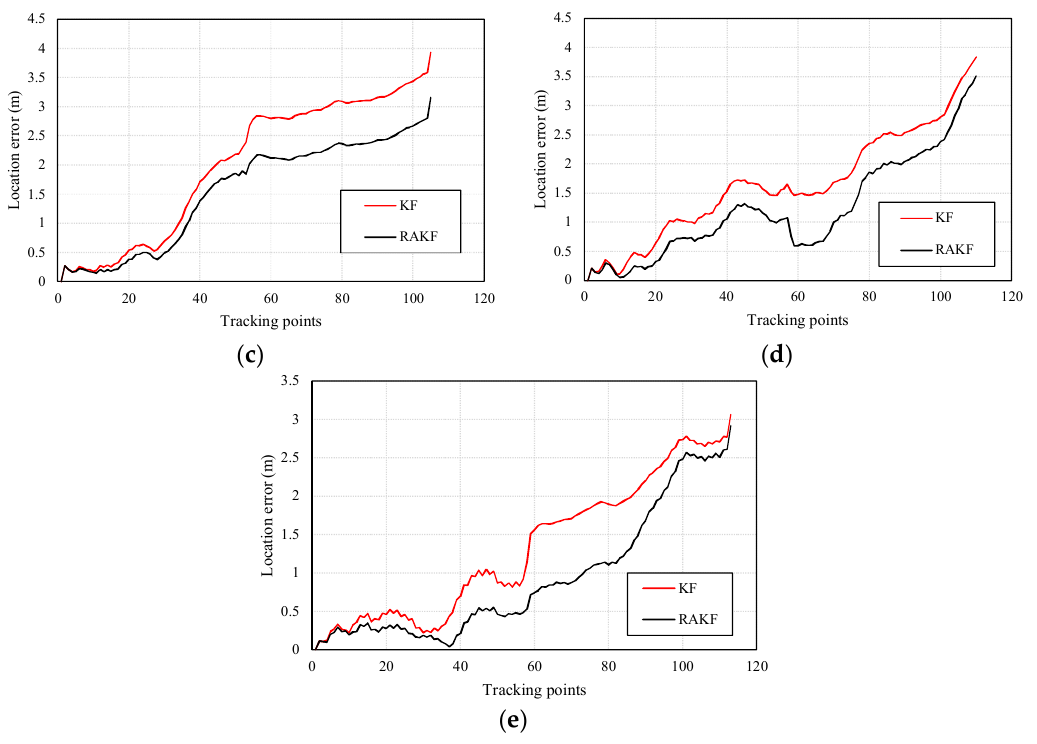
Figure 12. Distributions of location errors in location tracking of KF and RAKF regarding five participants, ( a ) participant 1, ( b ) participant 2, ( c ) participant 3, ( d ) participant 4, and ( e ) participant 5.